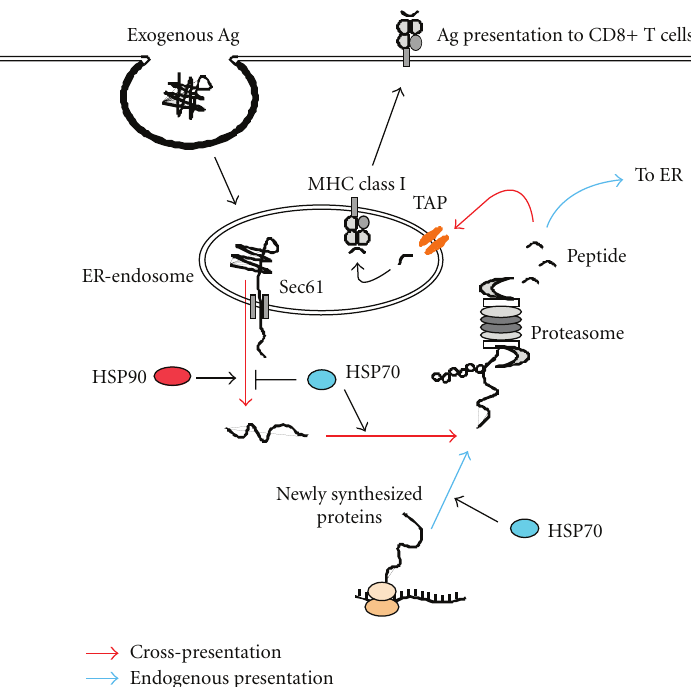
Figure 7: Model illustrating how HSP70 and HSP90 regulate cross-presentation and endogenous Ag presentation. In cross-presentation, internalized exogenous Ag is unfolded within the endosome and translocated through a putative translocon Sec61 complex into the cytosol. The translocation is facilitated by HSP90 but limited by HSP70. The translocated proteins are forwarded to the proteasome for degradation in HSP70-dependent manner. Ag-derived peptides generated by the proteasome enter the same endosome from which it dislocates to the cytosol through TAP molecules and associate with MHCI molecules. TAP molecules and MHCI molecules within the endosome are probably recruited from the endoplasmic reticulum (ER) in a Sec22b-dependent manner. In endogenous Ag presentation, a portion of newly synthesized, unfolded proteins are transported to the proteasome for their degradation by HSP70. Generated peptides enter the ER to associate with MHCI